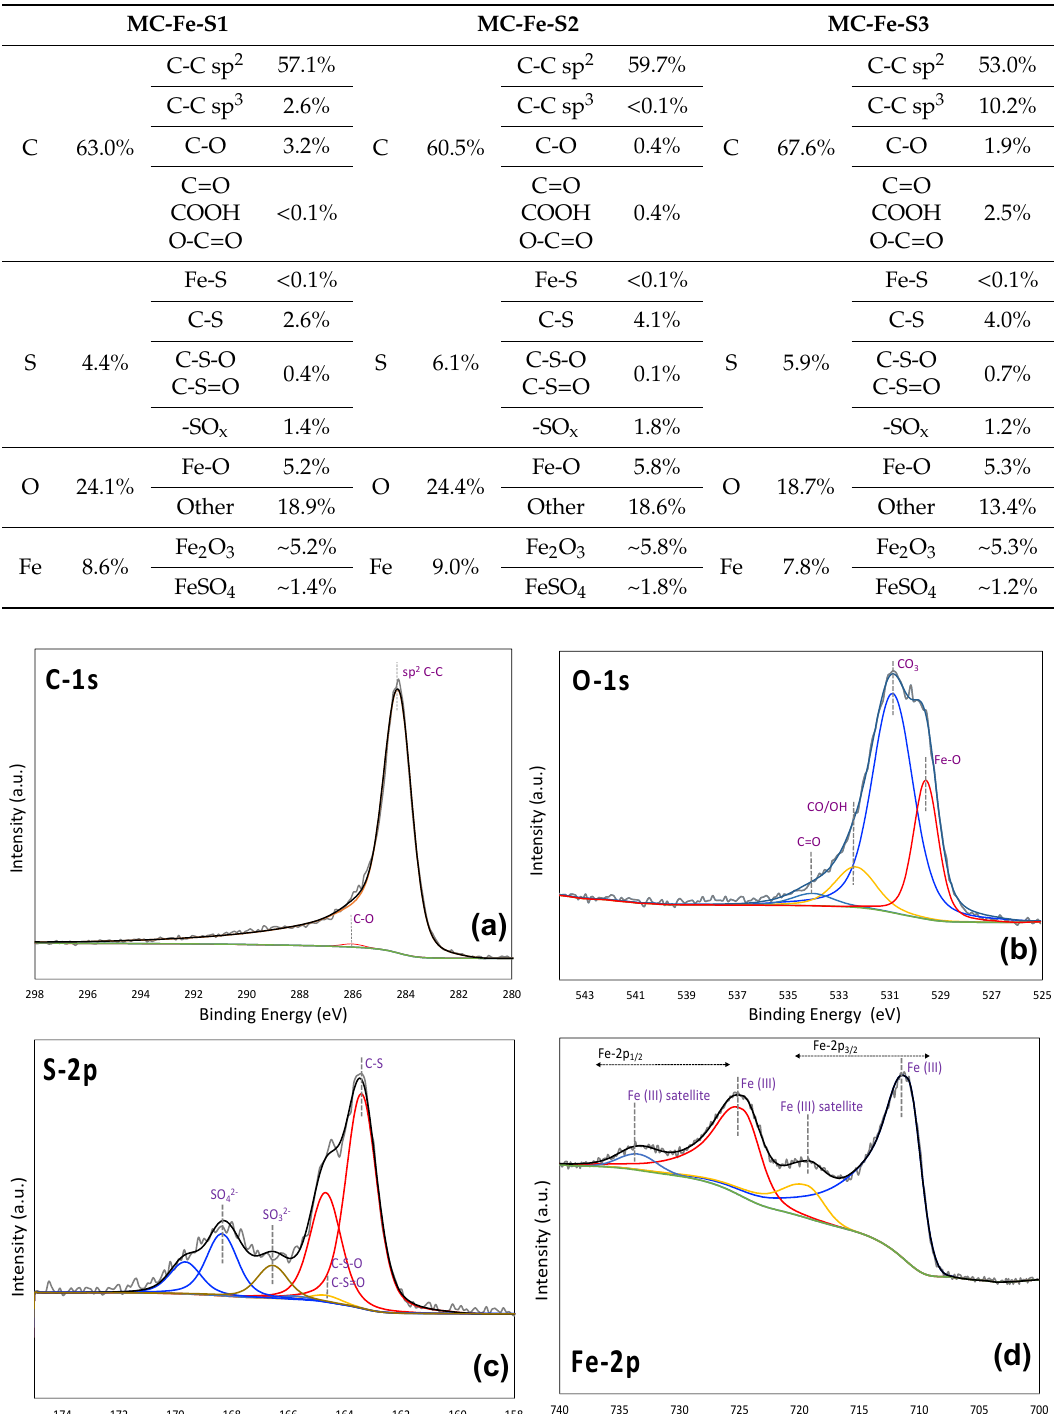
Table 2. Atomic contents of the mesoporous carbons, as obtained from XPS.